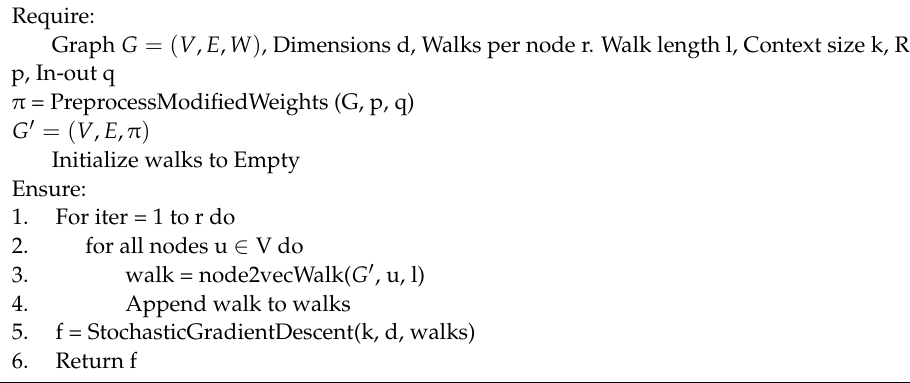
Algorithm 2: Learning Vector